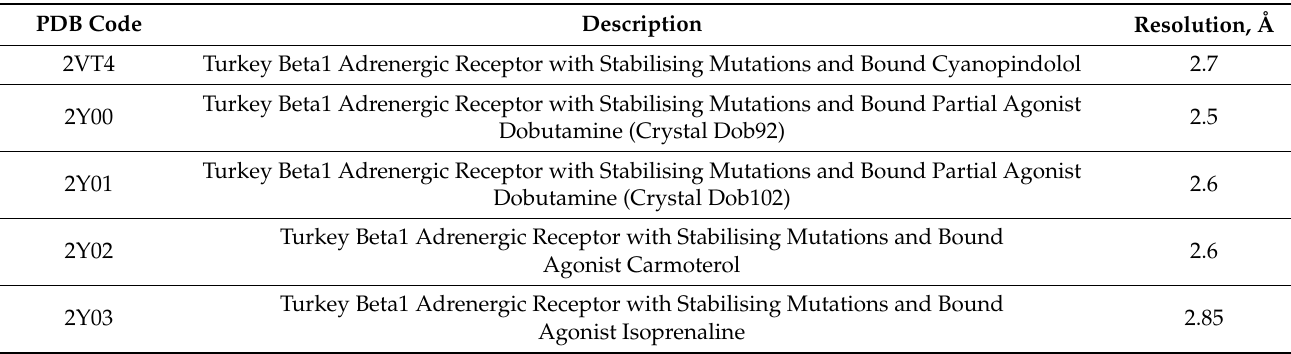
Table A5. A list of all β 1-adrenergic receptor ( β 1AR) receptor structures used in Figure 6. Included are the PDB code, description, and resolution in